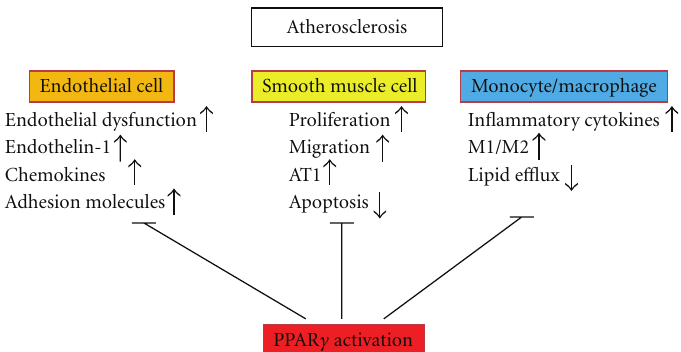
Figure 1: Action of PPAR γ on atherosclerotic lesion. PPAR γ act on endothelial cell, smooth muscle cell, and macrophage.